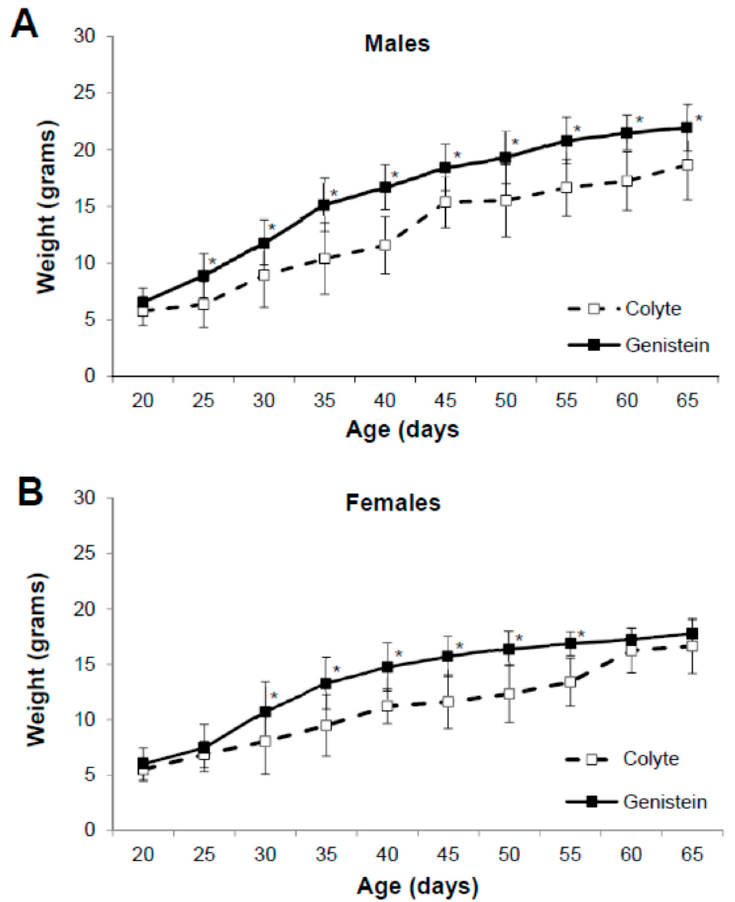
Figure 1. Effect of dietary genistein on body weight of ∆ F508-CF mice. Body weight was measured weekly from weaning (aged 20 days) and monitored up to age 65 days. ( A ) Weight of males on colyte ( n = 8) and genistein diet ( n = 14). ( B ) Weight of females on colyte ( n = 9) and genistein diet ( n = 15). Data are mean ± SD. * indicates significant genistein-mediated difference, p < 0.05.